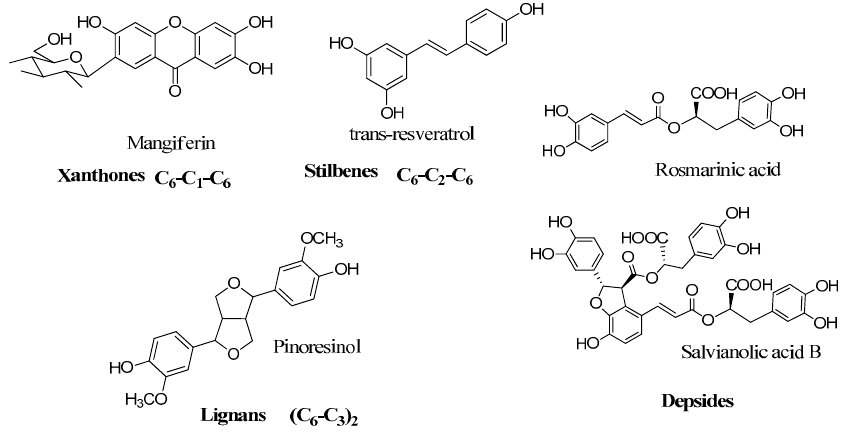
Figure 3. Some examples of polyphenolic classes.